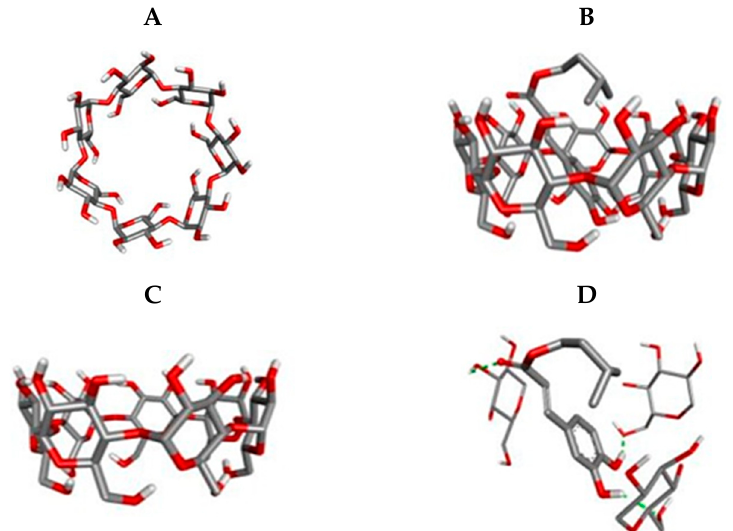
Figure 6. Molecular structure of β -CD ( A and C ), lowest docking energy conformation of ICaf with β -CD ( B ) and molecular interactions (H-bond) of ICaf with β -CD ( D ).